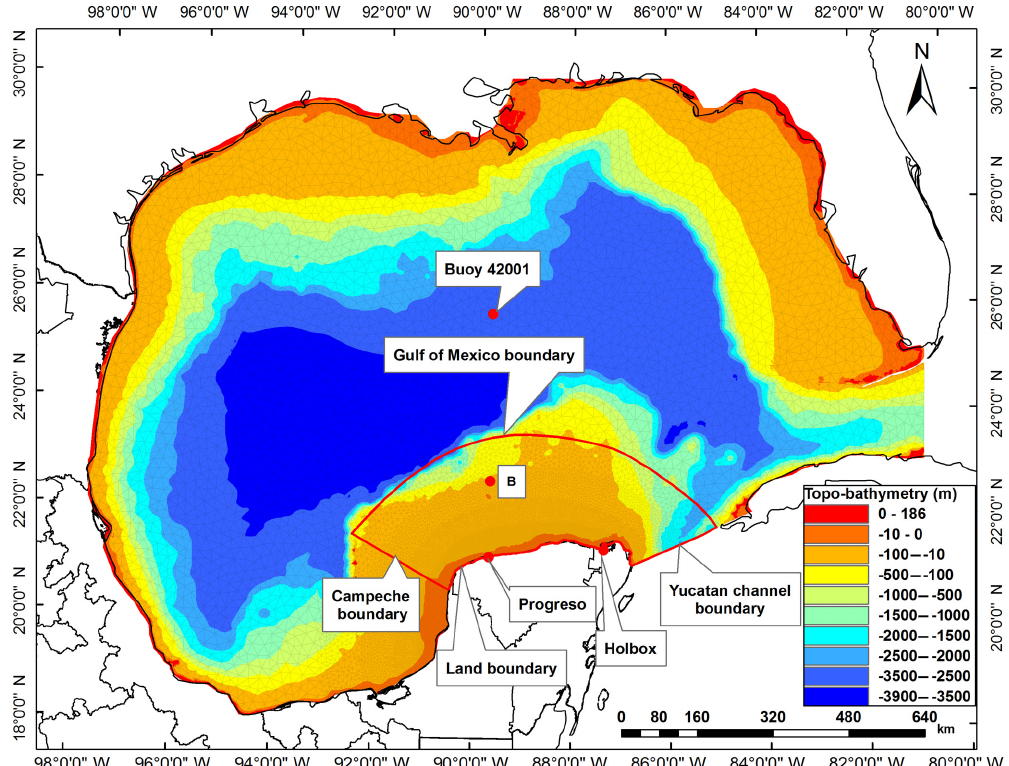
Figure 2. Computational domains and topo-bathymetry for the hydrodynamic and coupled models (polygon in red) as well as for the spectral wave model (entire Gulf of